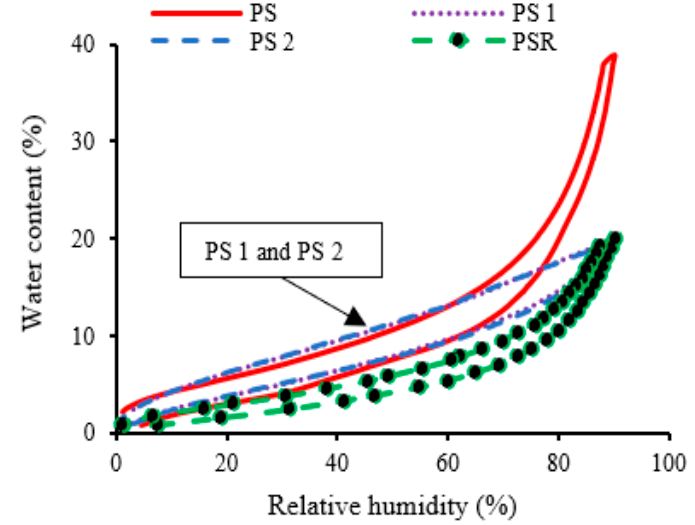
Figure 5. Sorption isotherms of PS fibers.